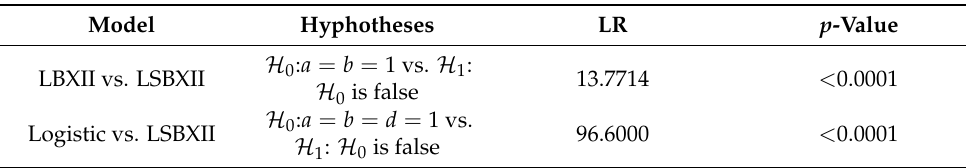
Table 8. LR tests for three